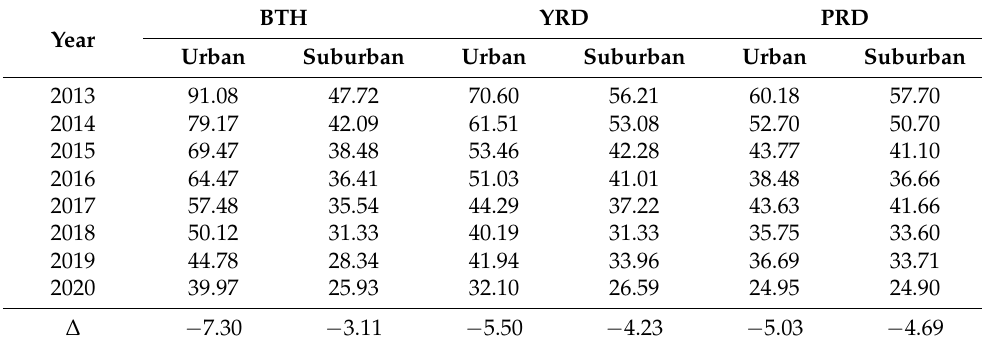
Table 2. The PM 2.5 concentrations ( µ g/m 3 ) in the urban and suburban areas of the three agglomera- tions and the percent change during the period